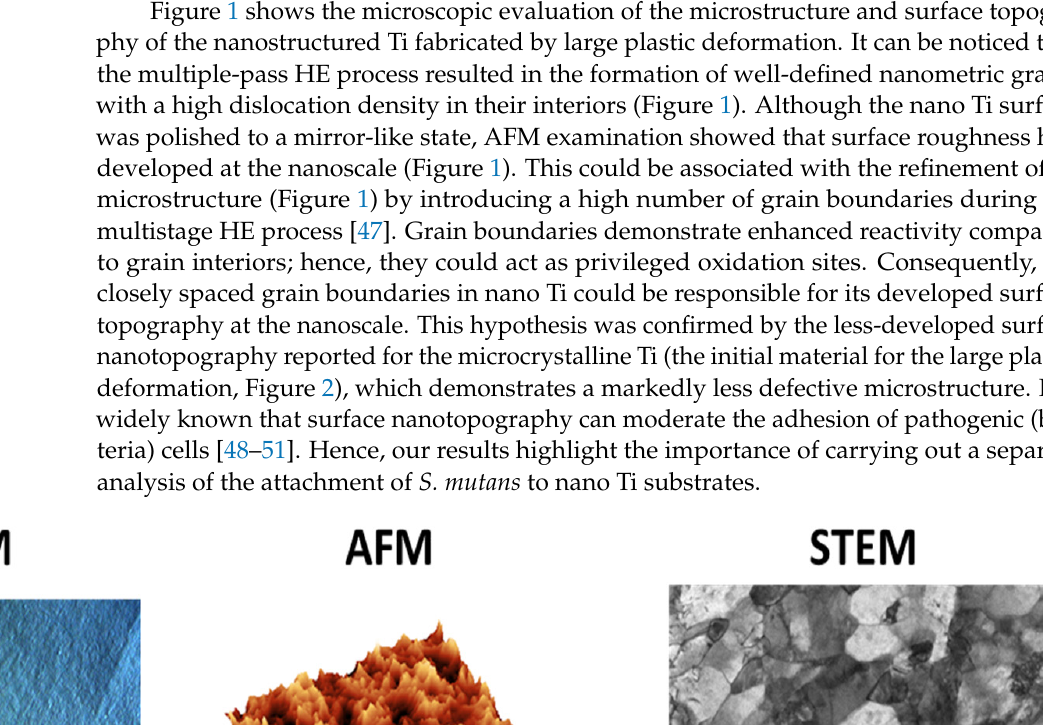
Table 1. Description of tested samples.